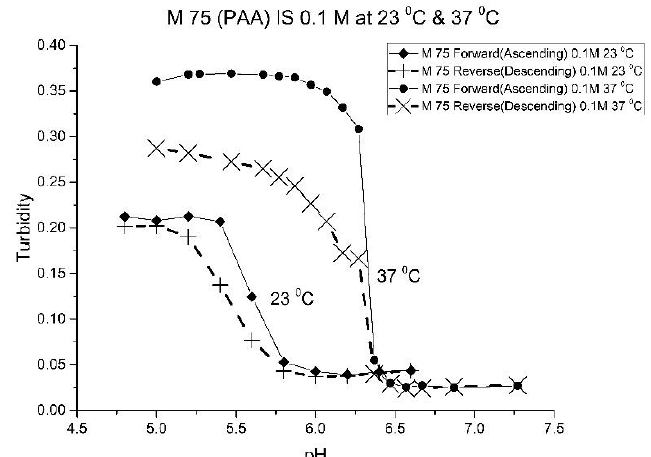
Figure 3. Ascending and descending pH profiles of polymer particles of M-83 (NIPA copolymerized with EAA) at 23 °C and 37 °C. Solid line = ascending pH profile. Dashed line = descending pH profile.